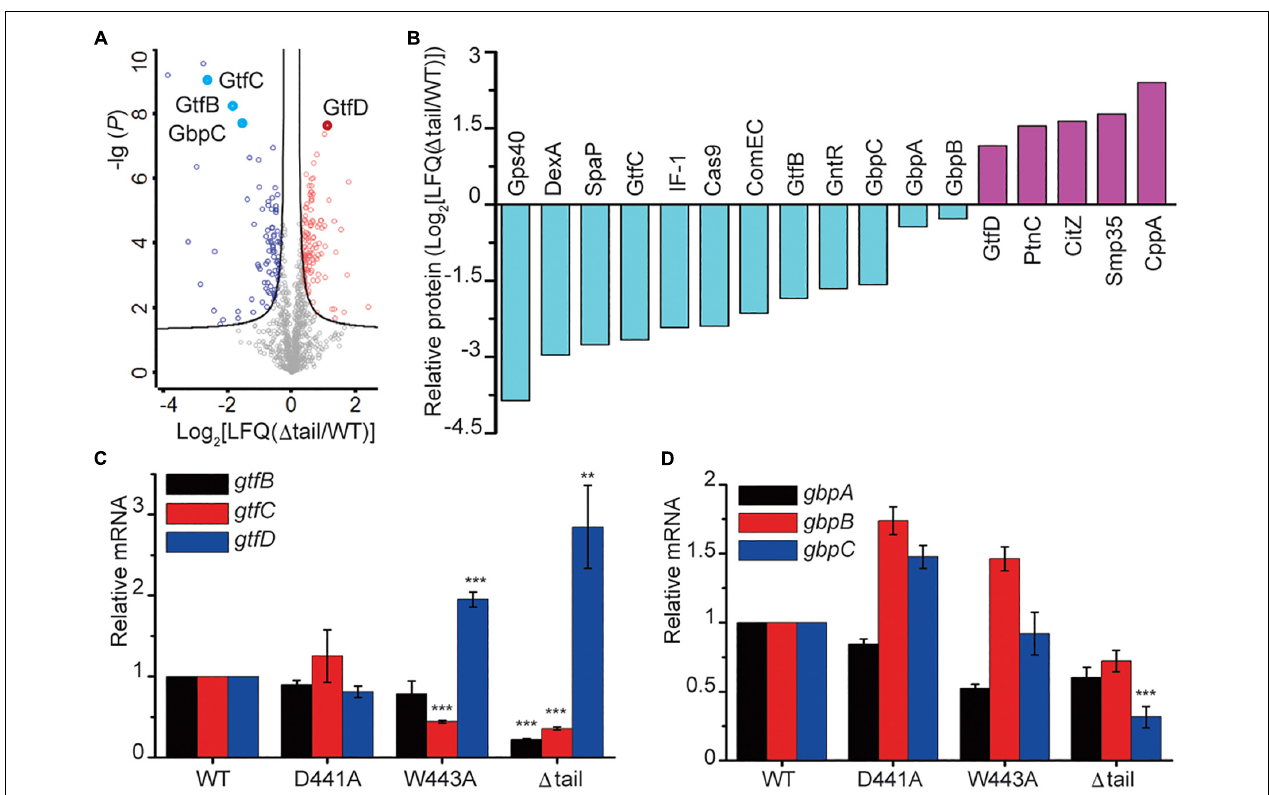
FIGURE 6 | Protein profiling in S. mutans biofilms. (A) Protein profiling of S mutans WT and (cid:49) tail strains from a quantitative mass spectroscopy experiment. The x -axis indicates the fold change of LFQ in the (cid:49) tail strain. The y -axis of log ( P ) indicates a significance level of the t- test. The black curves separate those proteins at a level of false discovery rate (FDR) = 0.01 and minimal fold changes (S0) = 0.1. Below the curve in gray are those unchanged proteins. Those proteins that were upregulated are colored in red, and those that were downregulated are colored in blue. Total and altered proteins are listed in MS Dataset. (B) Proteins that were most altered in the (cid:49) tail strain. Proteins were selected at a difference cutoff of > 1.5 except GbpA and GbpB. Five short, functionally unknown, peptides were excluded. The functional annotations of the proteins are shown in Supplementary Table 1 . (C,D) qRT-PCR analyses of key genes known to be regulated by WalRK. Transcriptional profiles of the genes gtfBCD and gbpABC were normalized to 16S RNA. Data presented are means ± standard deviations (error bars) for three independent experiments. Student’s t -tests were used to compare (cid:49) tail strain to WT strain (** p < 0.005 and *** p <